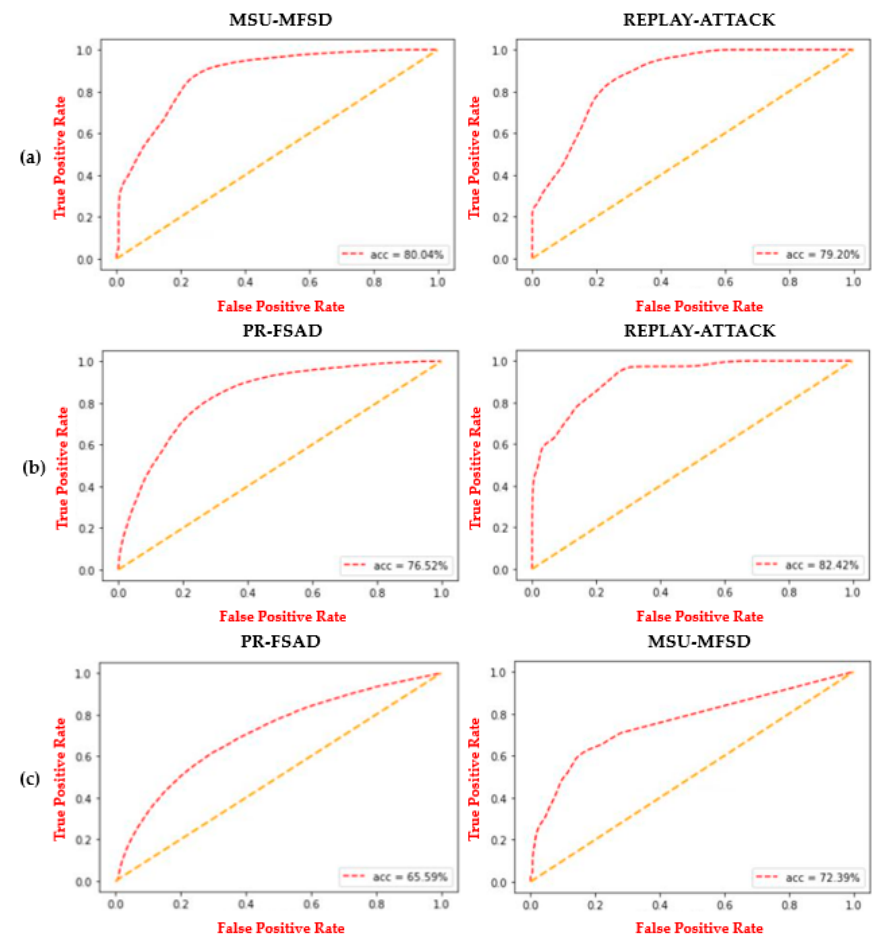
Figure 12. The result of ROC curve using the model trained with each of three databases: ( a ) PR-FSAD; ( b ) MSU-MFSD; and ( c ) REPLAY-ATTACK.